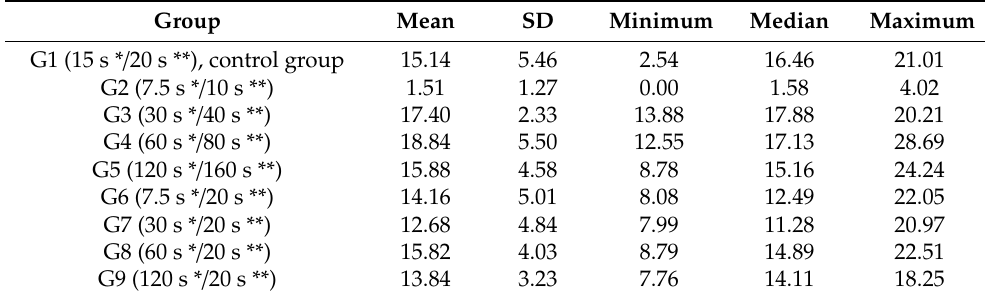
Table 2. Descriptive statistics of the microtensile bond strength (MPa) of all tested groups. Group Mean